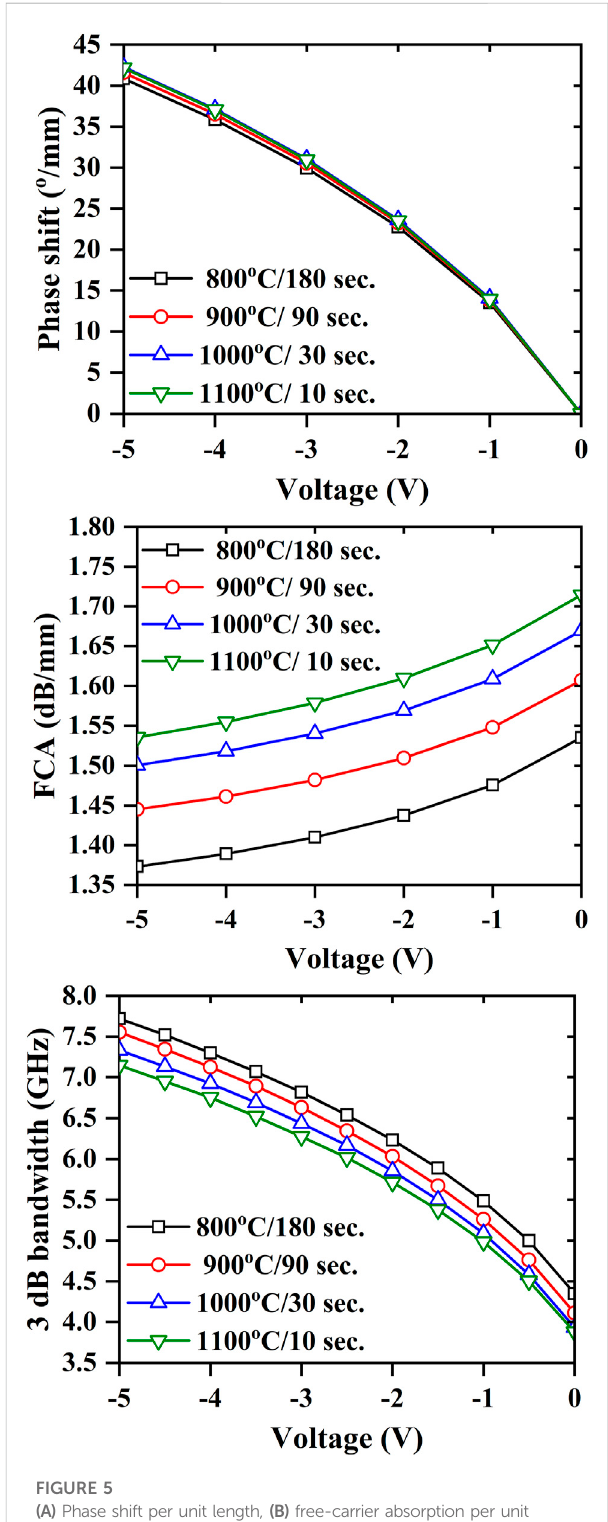
FIGURE 5 (A) Phase shift per unit length, (B) free-carrier absorption per unit length, and (C) 3-dB bandwidth for different annealing